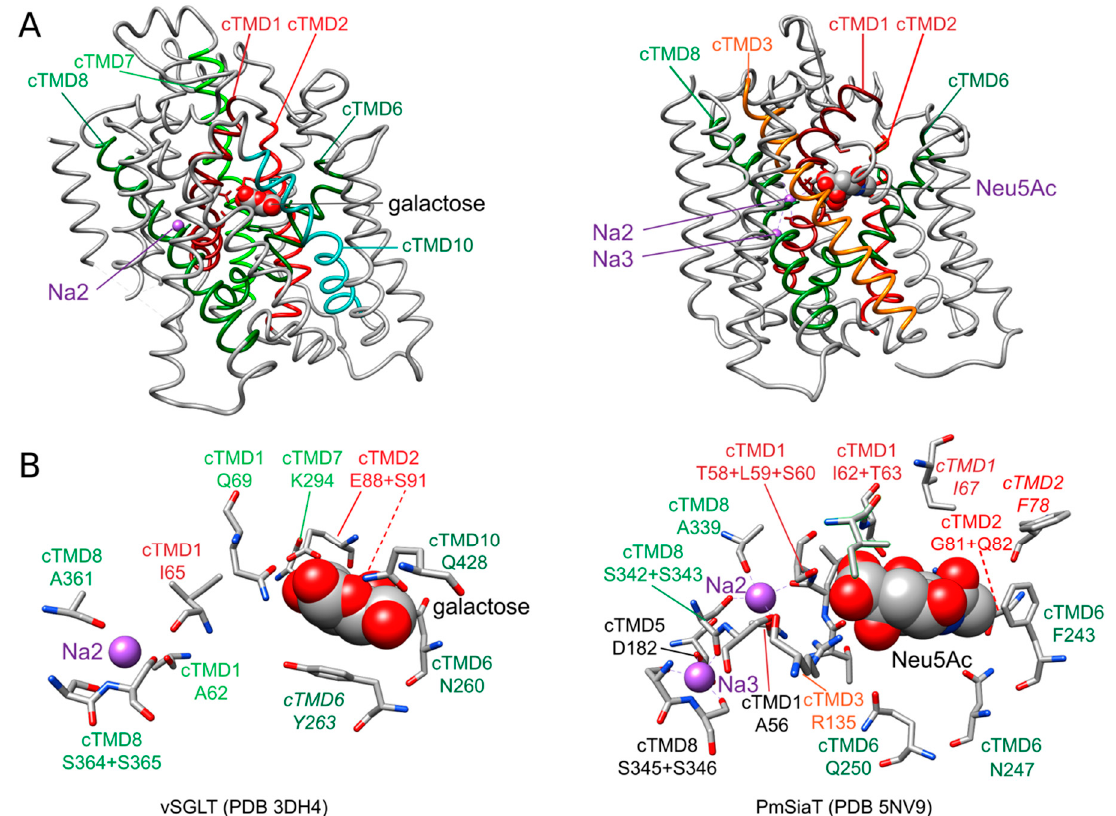
Figure 3. Sodium ion and substrate binding sites of vSGLT and PmSiaT. ( A ) Sideview of vSGLT and PmSiaT in the membrane plane. Core transmembrane domains (cTMDs) that coordinate with sodium ions and substrate are depicted in color, while the remaining TMDs are colored in grey. Substrates are shown as grey spheres colored by heteroatom and sodium ions are shown in purple. ( B ) Amino acids coordinating sodium ions or substrate. Amino acids are presented as grey sticks colored by heteroatom and substrates are presented as in ( A ). Amino acids positions highlighted in italics are considered to function as thin gates. Images were generated based on the crystal structures of vSGLT (3DH4) and PmSiaT (PDB 5NV9) using UCSF Chimera. Chimera is developed by the Resource for Biocomputing, Visualization, and